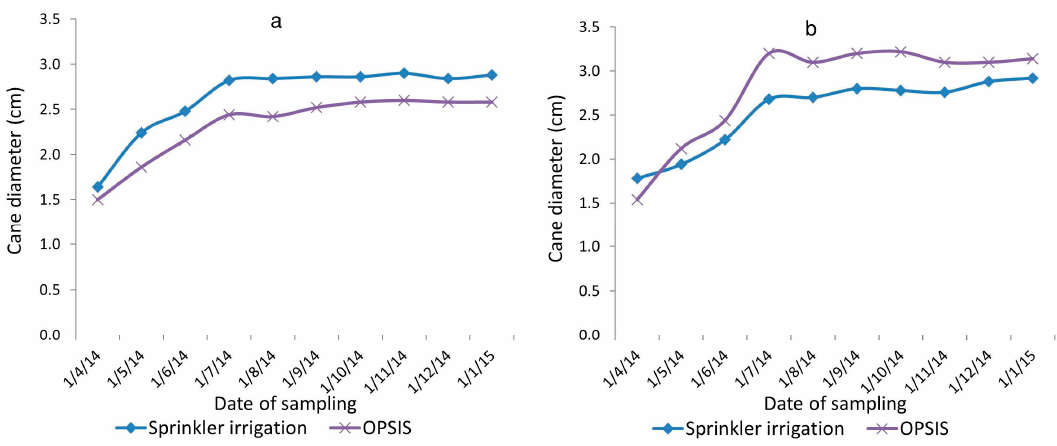
Figure 3. Average cane diameter of sugarcane cultivar Ni21 as affected by irrigation method in ( a ) the summer-planted main crop and ( b ) the first ratoon crop of spring-planted sugarcane.